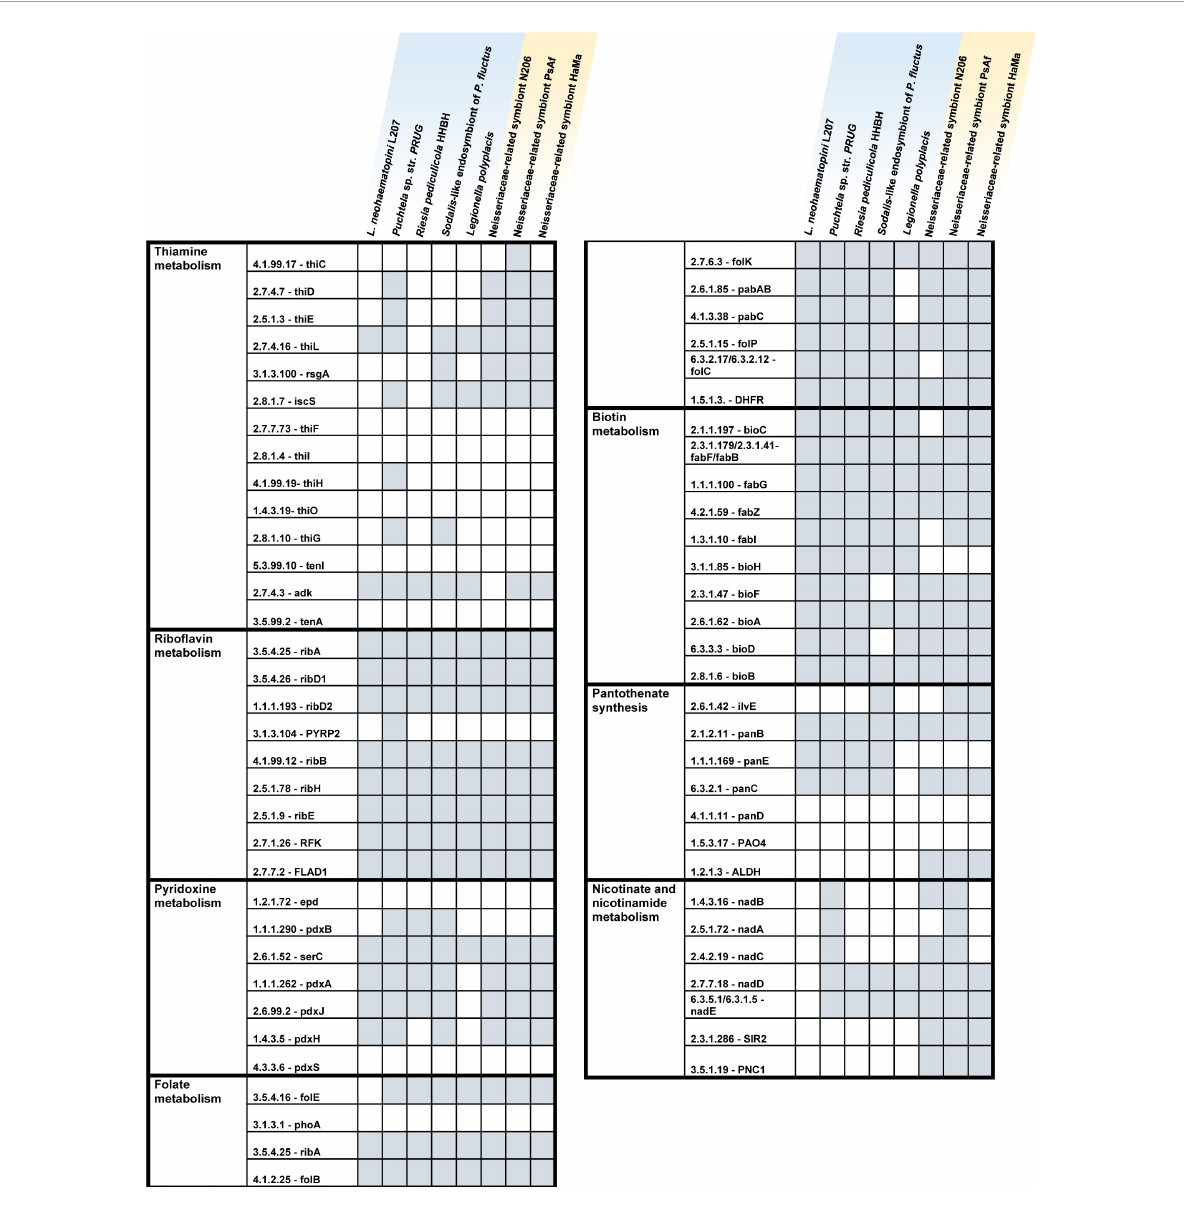
FIGURE3 Comparison of B-vitamins pathways for Lightella neohaematopini L207, Neisseriaeceae-related symbiont N206 and other louse symbionts (blue background = γ -proteobacteria, yellow background = β -proteobacteria). Presence of the particular genes is indicated by gray